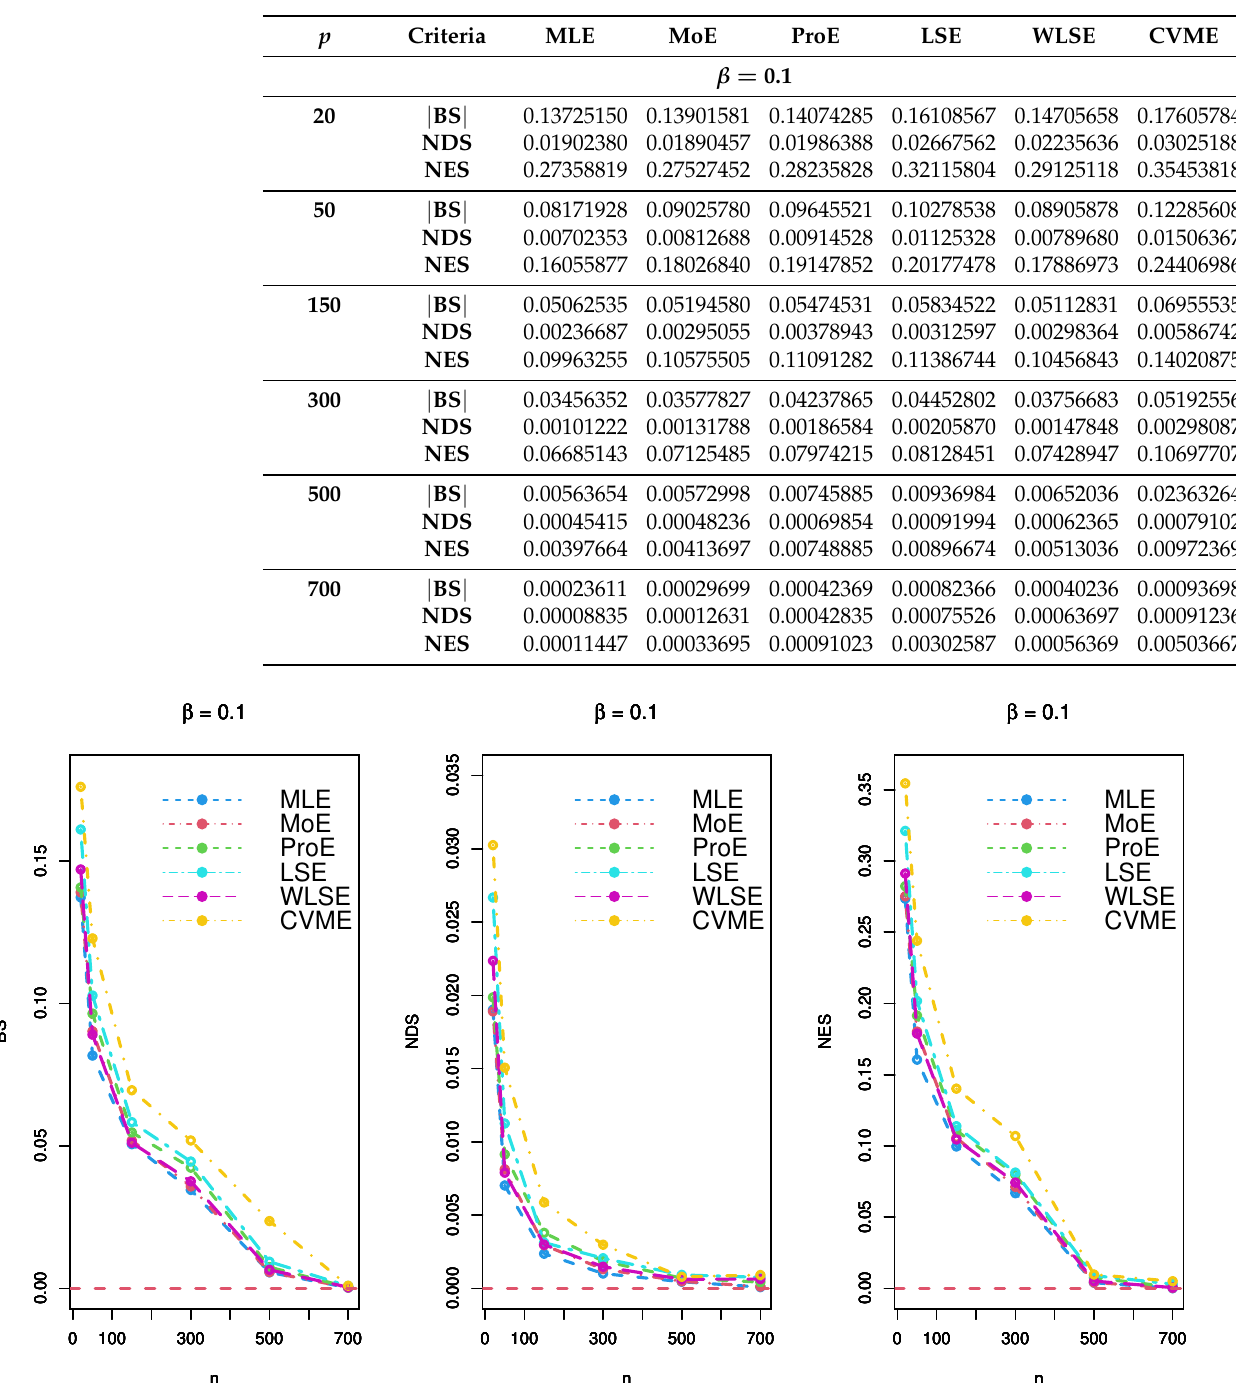
Figure 3. Simulation results for β = 0.1 under various estimation